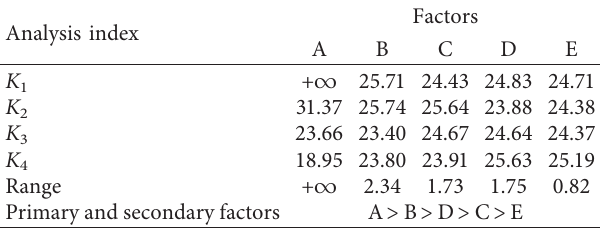
Table 8: Range analysis of slurry